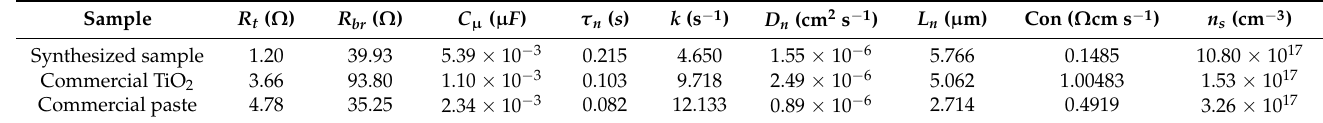
Figure 13. Nyquist plot of the impedance analysis of the synthesized sample, the commercial TiO 2 , and the commercial paste. Table 3. Electrochemical properties of the synthesized sample, the commercial TiO 2 , and the commercial paste.